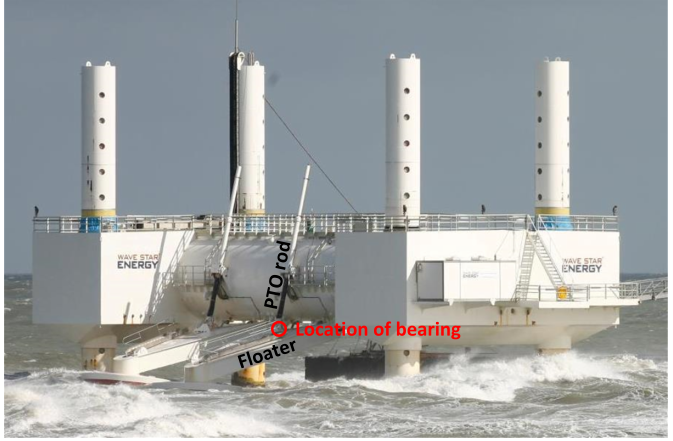
Figure 2. Wavestar prototype located at Hanstholm (Denmark) showing the location of the investigated bearing. Power take-off: PTO.